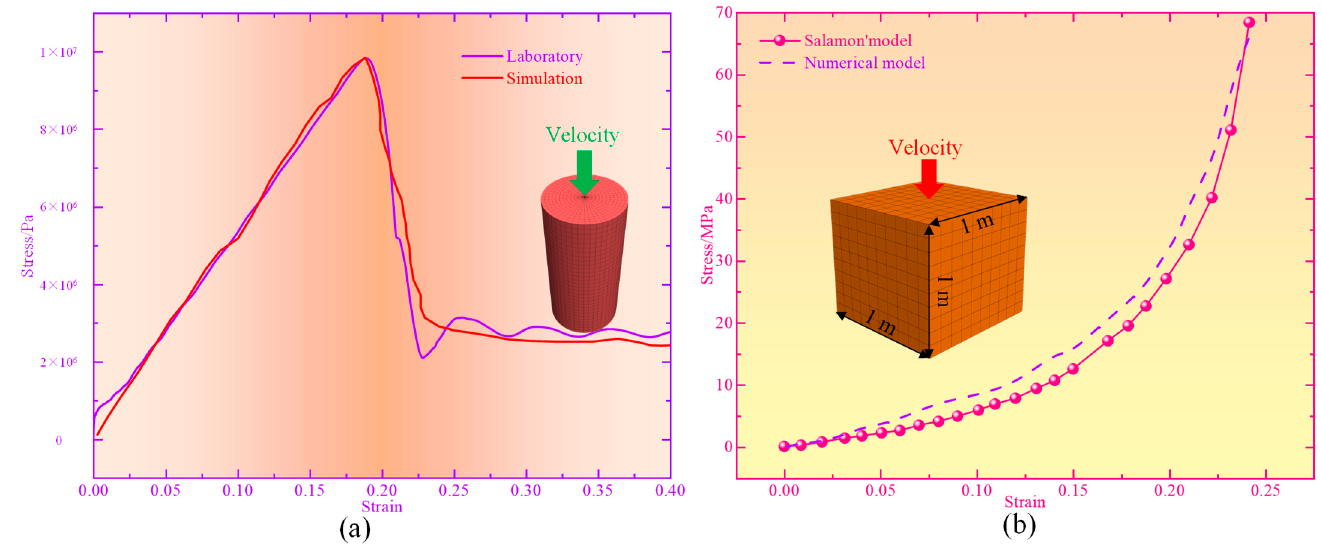
Figure 21. Inversion fitting process of constitutive model parameters in numerical simulation: ( a ) strain-softening model and ( b ) double-yield model.